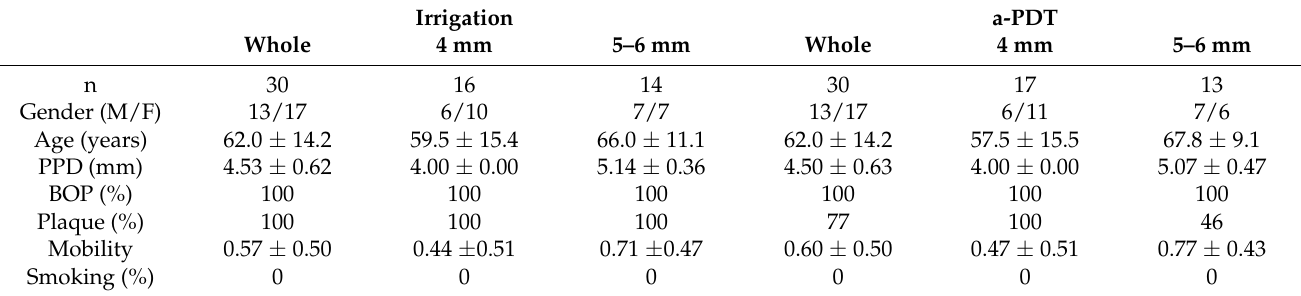
Table 1. Basic characteristics of the study population at baseline.